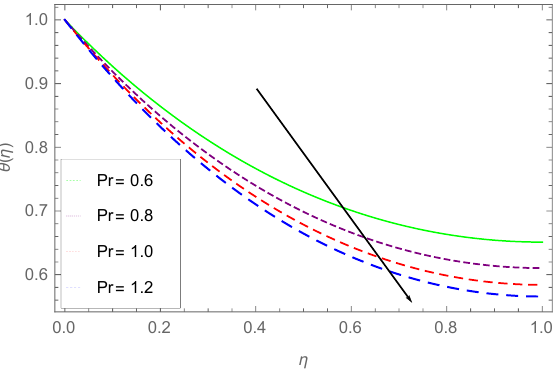
Figure 5. Impact of Pr on θ ( η ) , when S = 0.7, β = 1.0, (cid:101) = 0.4, Nb = 0.5, Nt = 0.3, Sc =